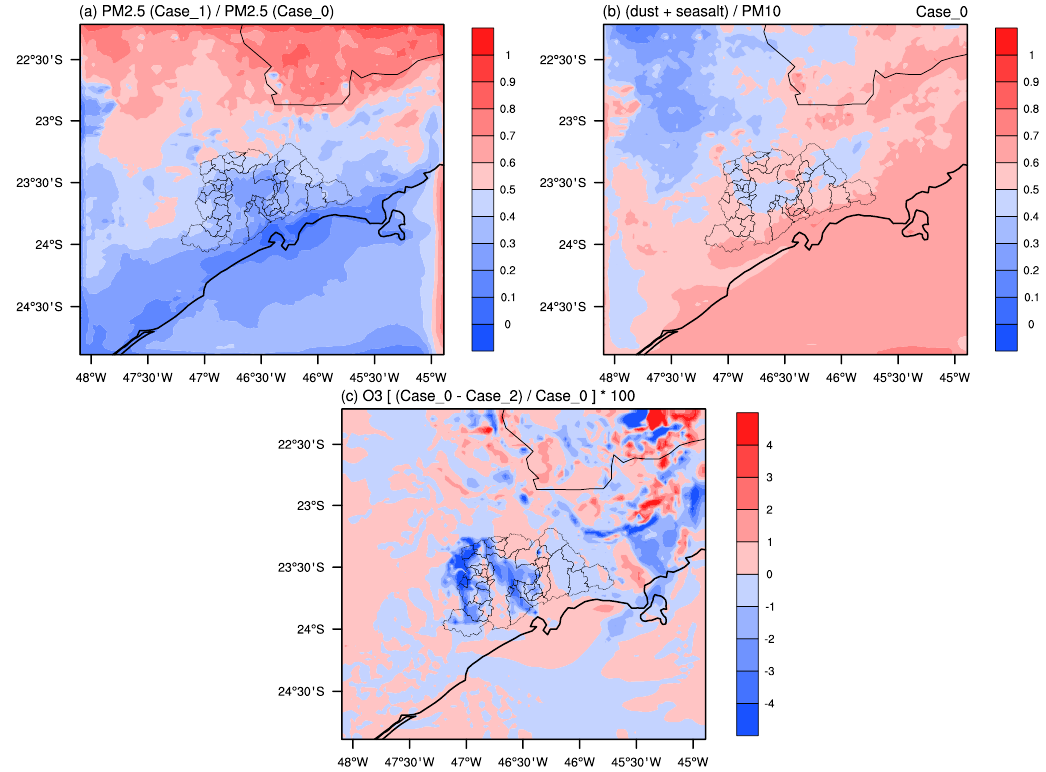
Figure 17. The impact of (a) emissions of primary gases on the fine particles formation, (b) emissions of dust-sea salt aerosols on the PM 10 concentration, and (c) aerosol direct effect on the ground level O 3 concentrations at 16:00 (local time). break molecules of O 3 and NO 2